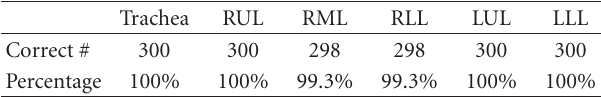
Table 1: Airway labeling accuracy in terms of